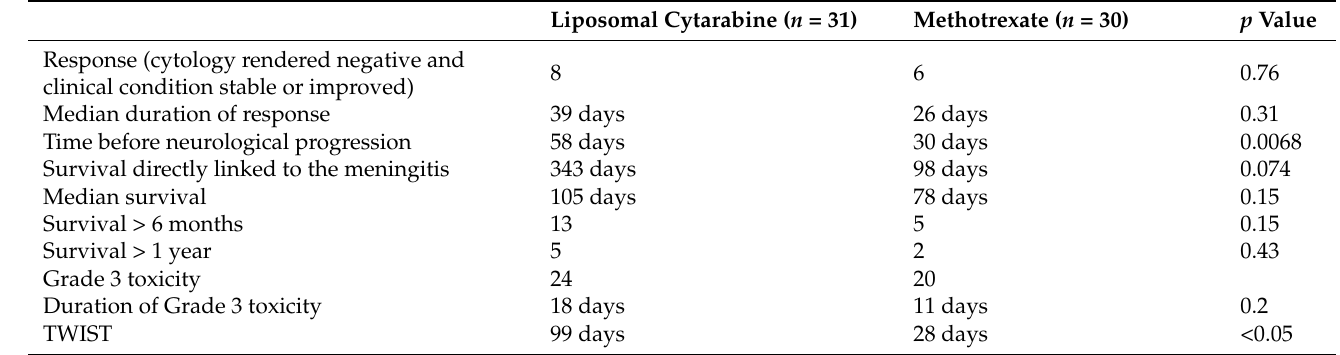
Table 2. Comparison of key results associated with liposomal cytarabine versus methotrexate, both injected intrathecally. TWIST = time elapsed without symptoms or toxicity. n = number of patients. Reproduced with permission from Beauchesne P. Intrathecal chemotherapy for treat- ment of leptomeningeal dissemination of metastatic tumors. Lancet Oncol. 2010; 11(9):